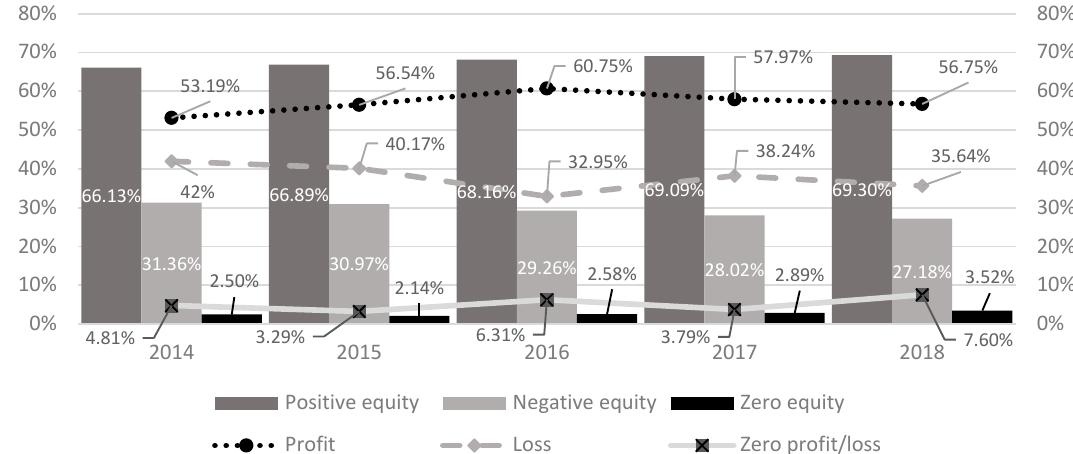
Figure 3. The structure of the examined sample of businesses according to the value of equity and profit or loss after tax in the monitored period.